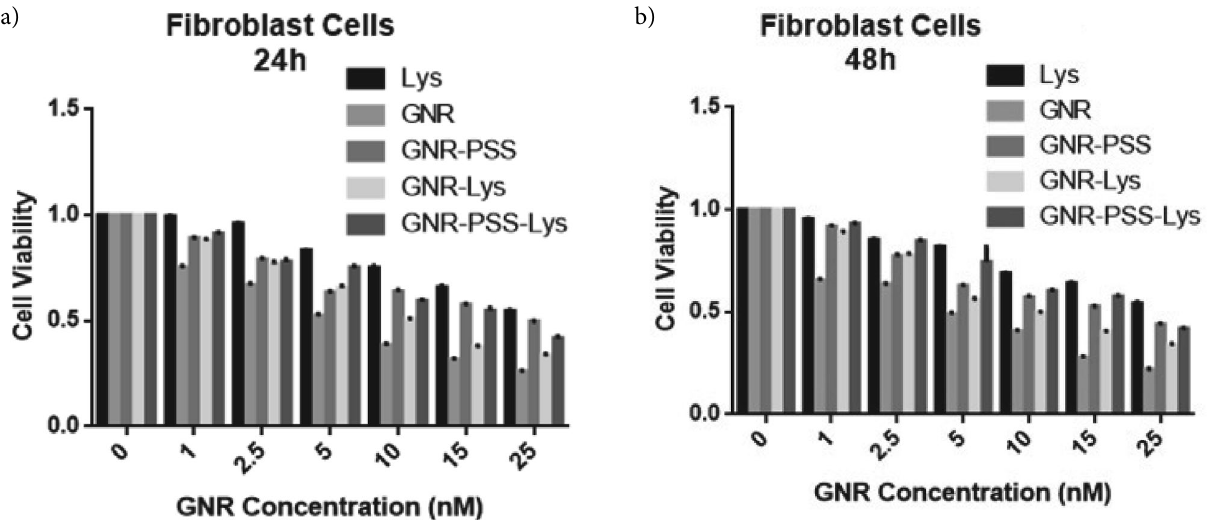
Figure 7. Cell viability assay for fibroblast cell line incubated for 24 h (a) and 48 h (b) with Lys, GNRs, GNRs-PSS, GNRs-Lys and GNRs-PSS-Lys. The abbreviation Lys represents Lysozyme Amyloid Fibrils.